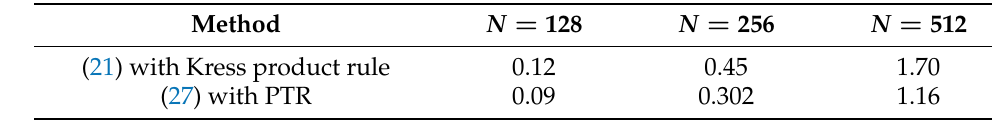
Table 5. Helmholtz 2D. CPU times (in seconds) for various number of quadrature points to compute the solution of the boundary integral equation.